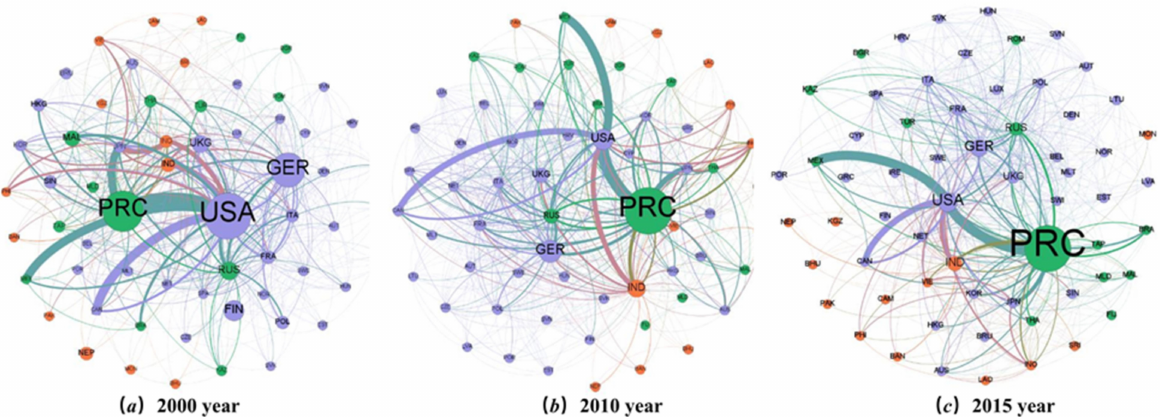
Figure 1. VWT network. Note: The color of the nodes represents the income level. Blue represents high-income countries; green represents middle-income countries; and red represents lower-income countries. The size of the node represents the centrality of the country in the trade